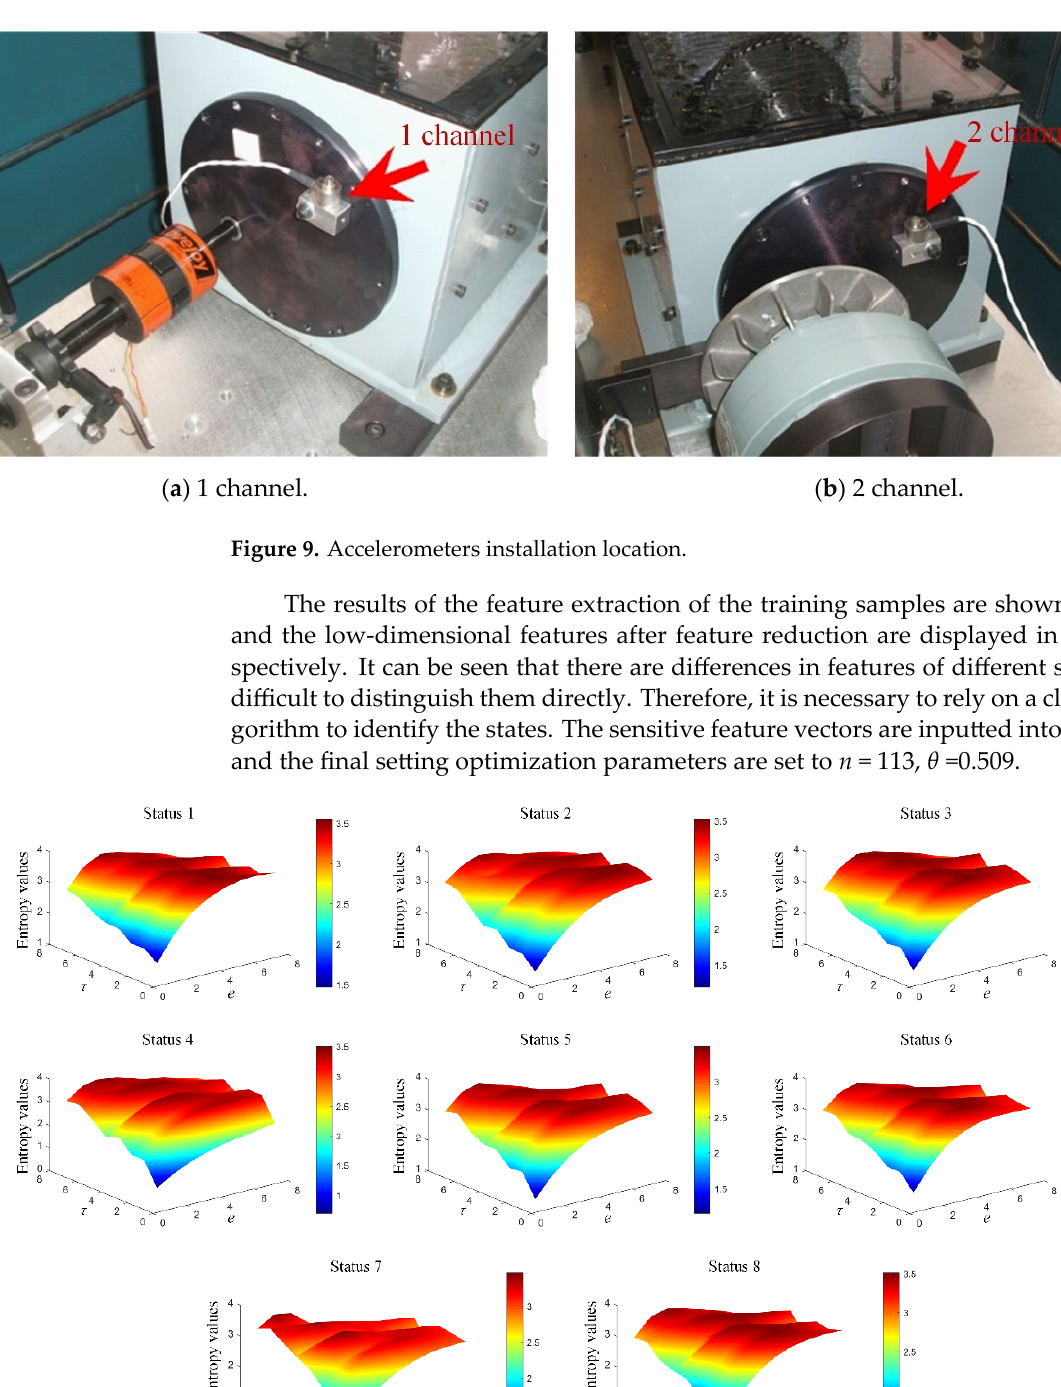
Figure 8. Waveforms corresponding to different states.